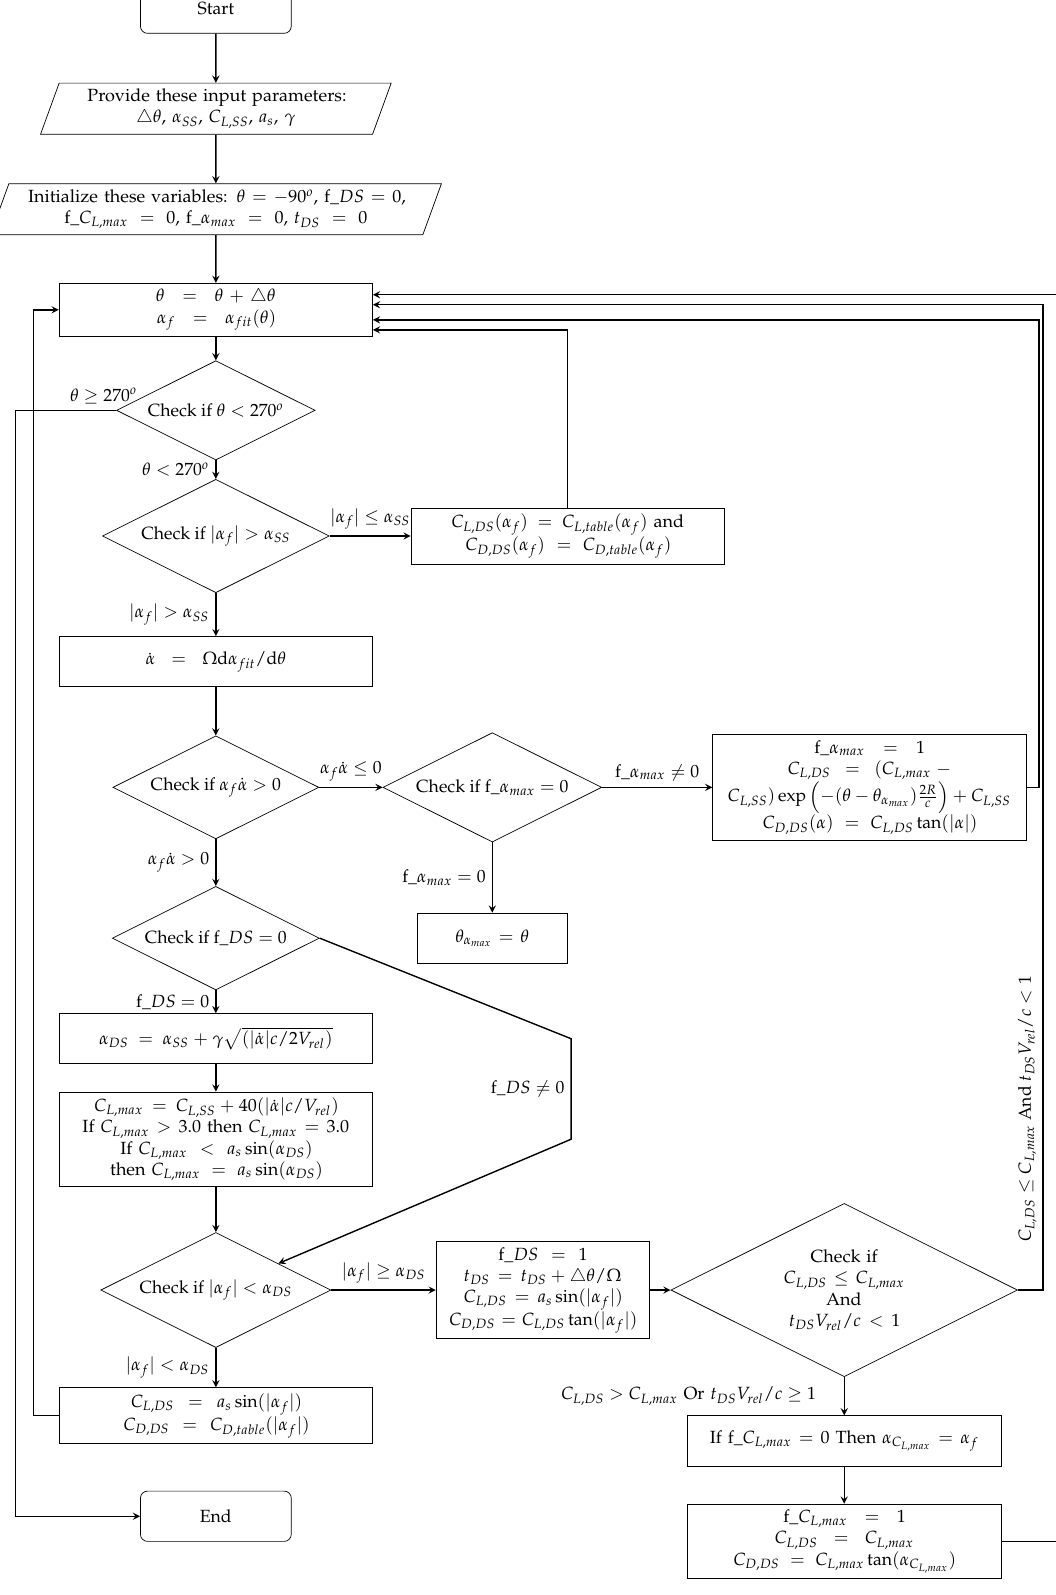
Figure A3. Flowchart to implement the modified MIT dynamic stall model for a VAWT in turbulent